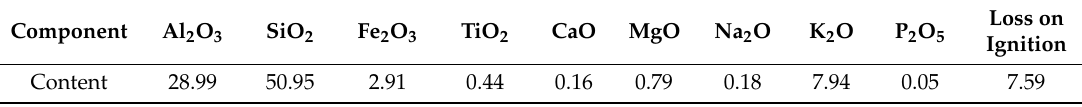
Table 1. Chemical composition of sericite